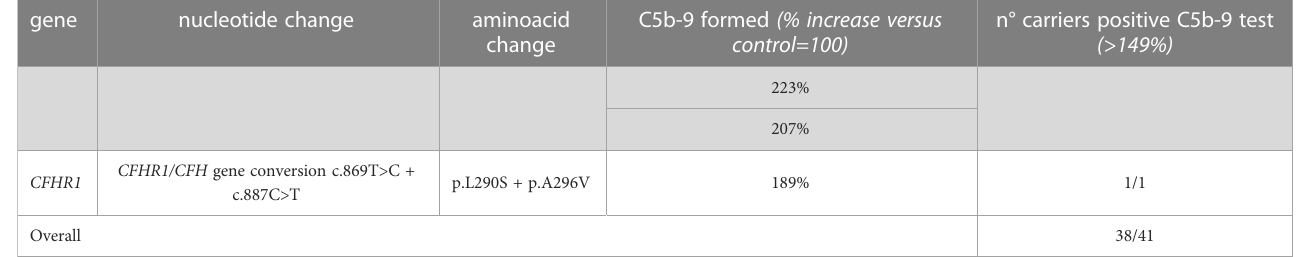
(Supplementary Figure 4), con fi rming that the ex vivo assay can reproduce the “ two hit ” model of aHUS. Results for 2 representative pedigrees are shown in Figure 2B (#267) and Figure 2C (#1245). The detailed clinical and family history of the 2 pedigrees are reported in the Supplementary Material.